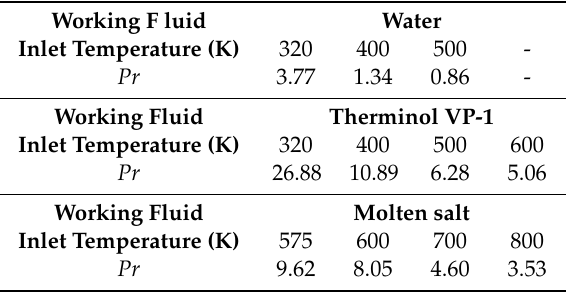
Table 9. E ff ective Pr number of all working fluids examined in the current study.